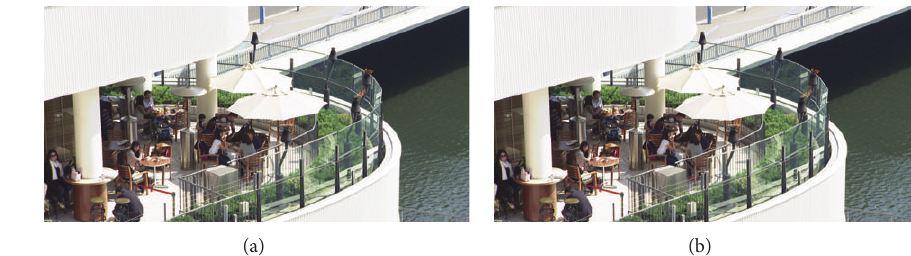
Figure 6: Class B (BQTerrace-QP 27, the 30th frame): (a) the original picture and (b) the decoded picture by the proposed algorithm.